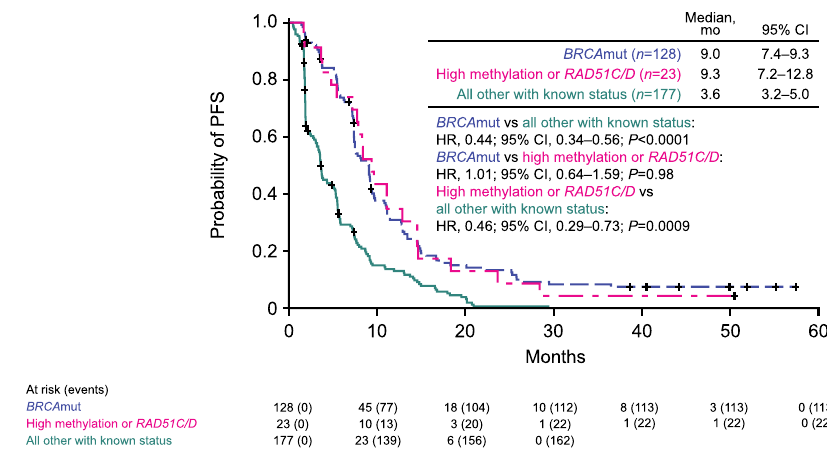
Fig. 5 High BRCA1 methylation at pretreatment or the presence of a RAD51C/D mutation result in similar PFS as the presence of BRCA mutations. PFS of patients with BRCA mut HGOCs, excluding cases with reversion mutations (blue), patients with HGOCs harboring a RAD51C/D mutation or high methylation at pretreatment (magenta), and all other patients with known mutation and methylation status, including cases with reversion mutations (teal). P values were computed using a Cox proportional hazard model. BRCA BRCA1 or BRCA2 , CI con fi dence interval, HGOC high-grade ovarian carcinoma, HR hazard ratio, mut mutated, PFS progression-free